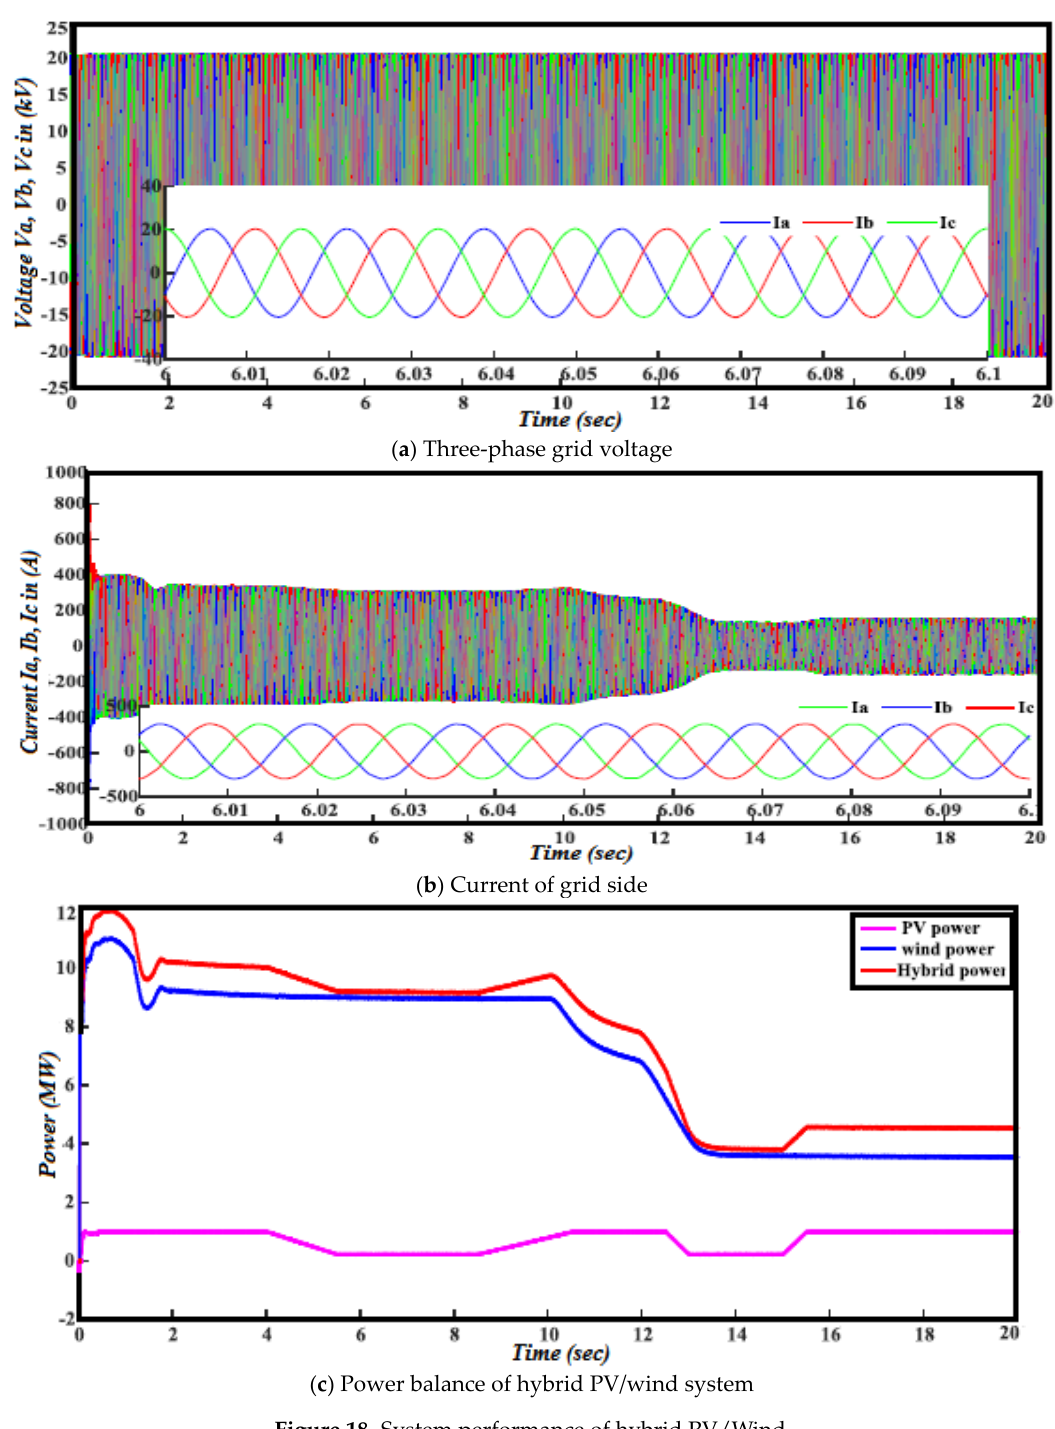
Figure 18. System performance of hybrid PV/Wind.